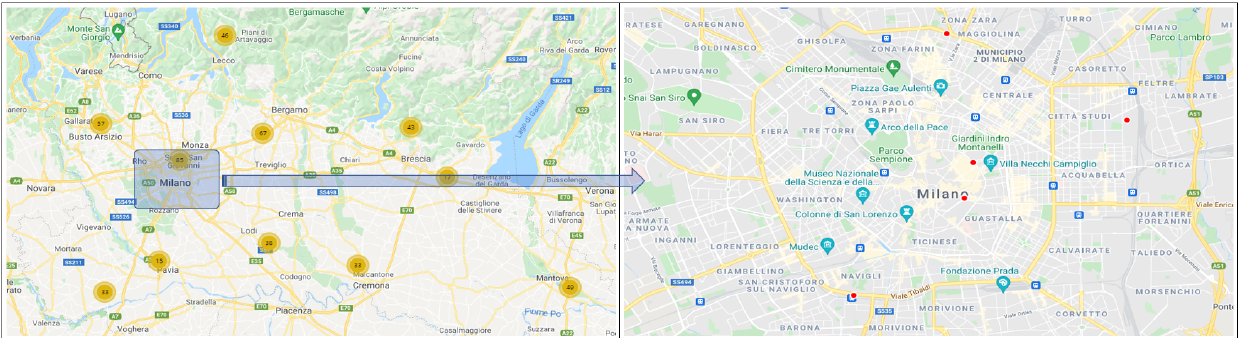
Figure 3. Locations of the 506 active air-quality sensors on a regional scale ( left-hand side ) and of the 5 nitric oxide sensors (red-dots) within the city of Milan ( right-hand side